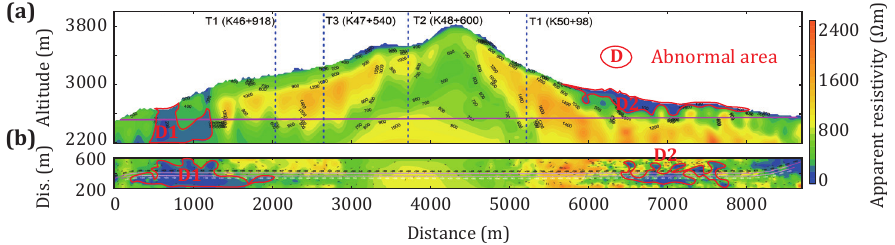
Figure 9. Apparent resistivity results: ( a ) apparent resistivity slices of the tunnel; ( b ) apparent resistivity map at the depth of the